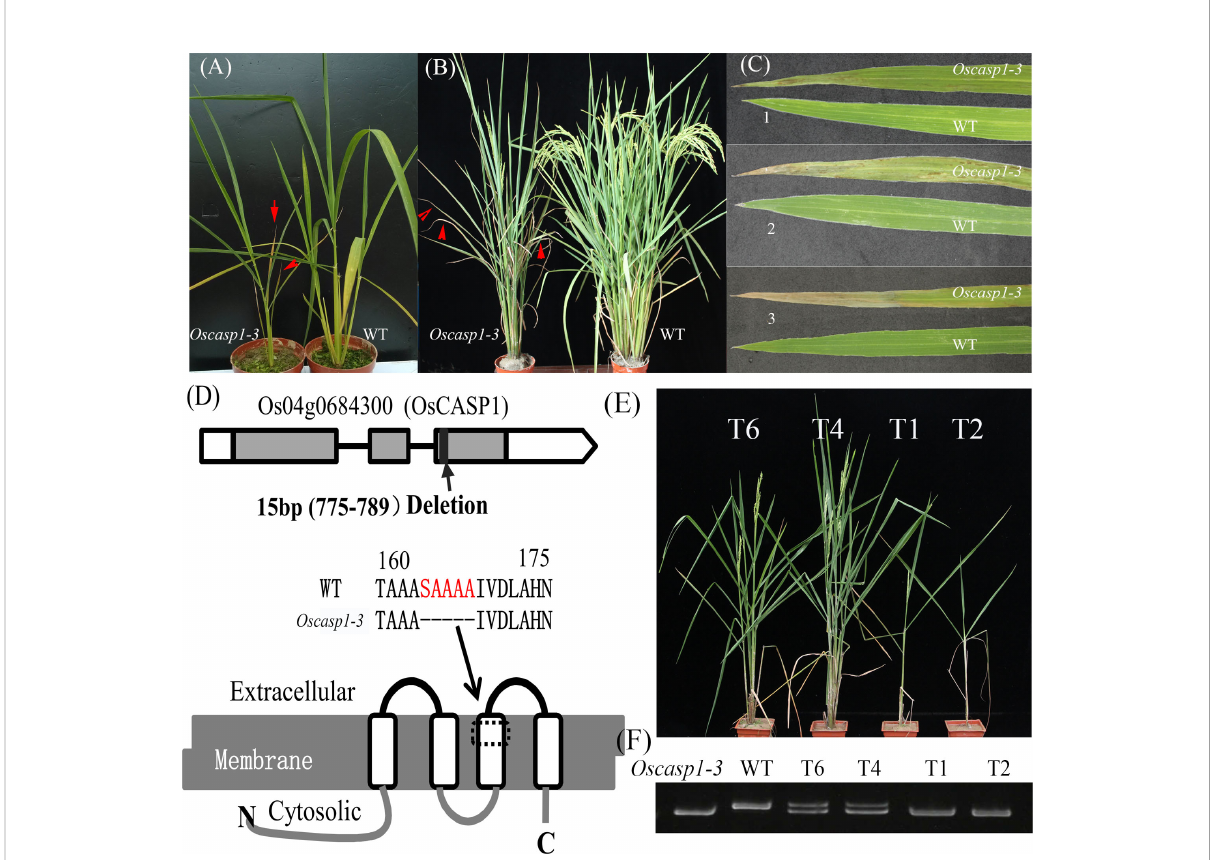
FIGURE 1 The phenotypes of the wild type and Oscasp1-3 mutant and characterization of Oscasp1-3 . (A) Seedlings of wild type and Oscasp1-3 mutant plants. (B) The phenotypes of wild type and Oscasp1-3 mutant plants at the heading stage. Red arrows indicate leaves with necrosis. (C) Phenotype of the leaves. 1, 2, and 3 indicate the relative positions from top to bottom. (D) The structure of OsCASP1 and deletion region in the Oscasp1-3 mutant. (E) Phenotypic comparison of transgenic plants with the OsCASP1 gene (T6 and T4) and segregant individuals without the OsCASP1 gene (T1 and T2). (F) The PCR result indicated transgenic plants with or without the OsCASP1